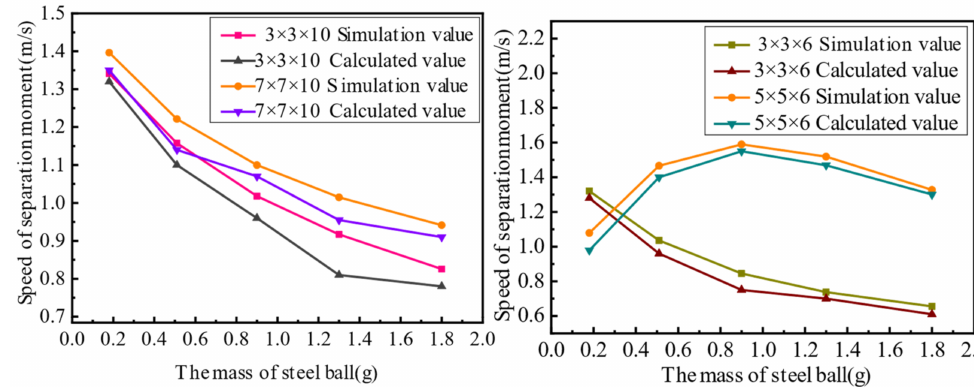
Figure 8. Comparison of simulated and experimental values in the second set of experiments.